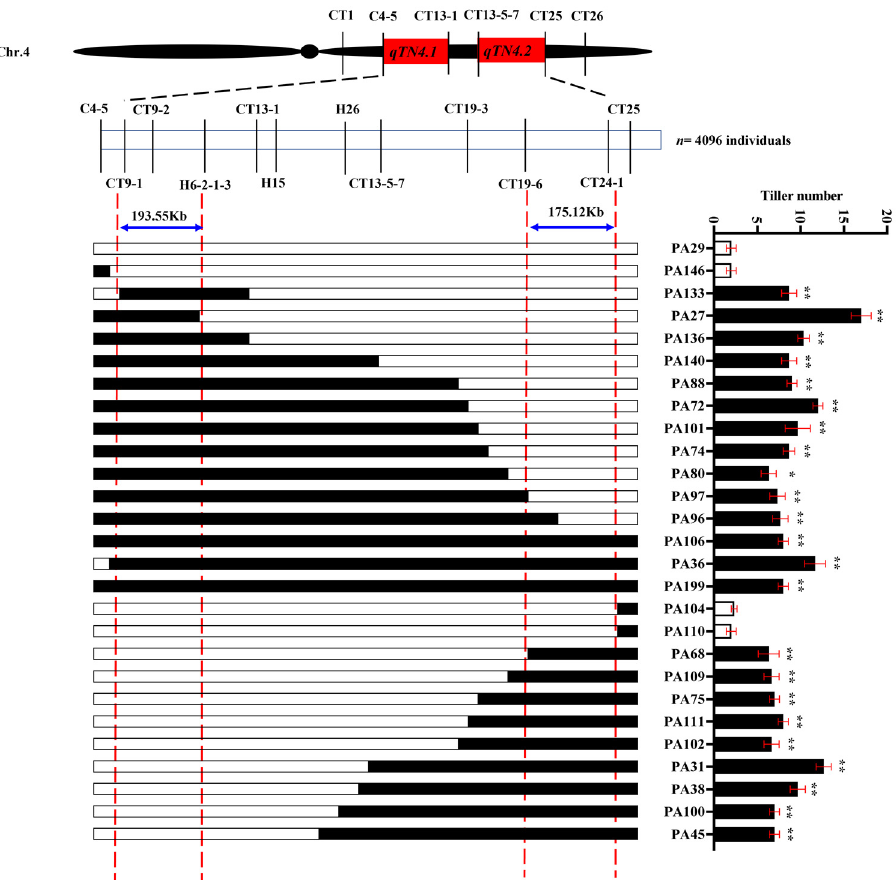
Figure 6. Genetic mapping, dissection, and physical maps of qTN4.1 and qTN4.2 . The black regions indicate that the regions are homozygous for the ZH9308 genome. The white regions indicate that the regions are homozygous for the XQZB genome. * p < 0.05, ** p < 0.01, Student’s t -test.